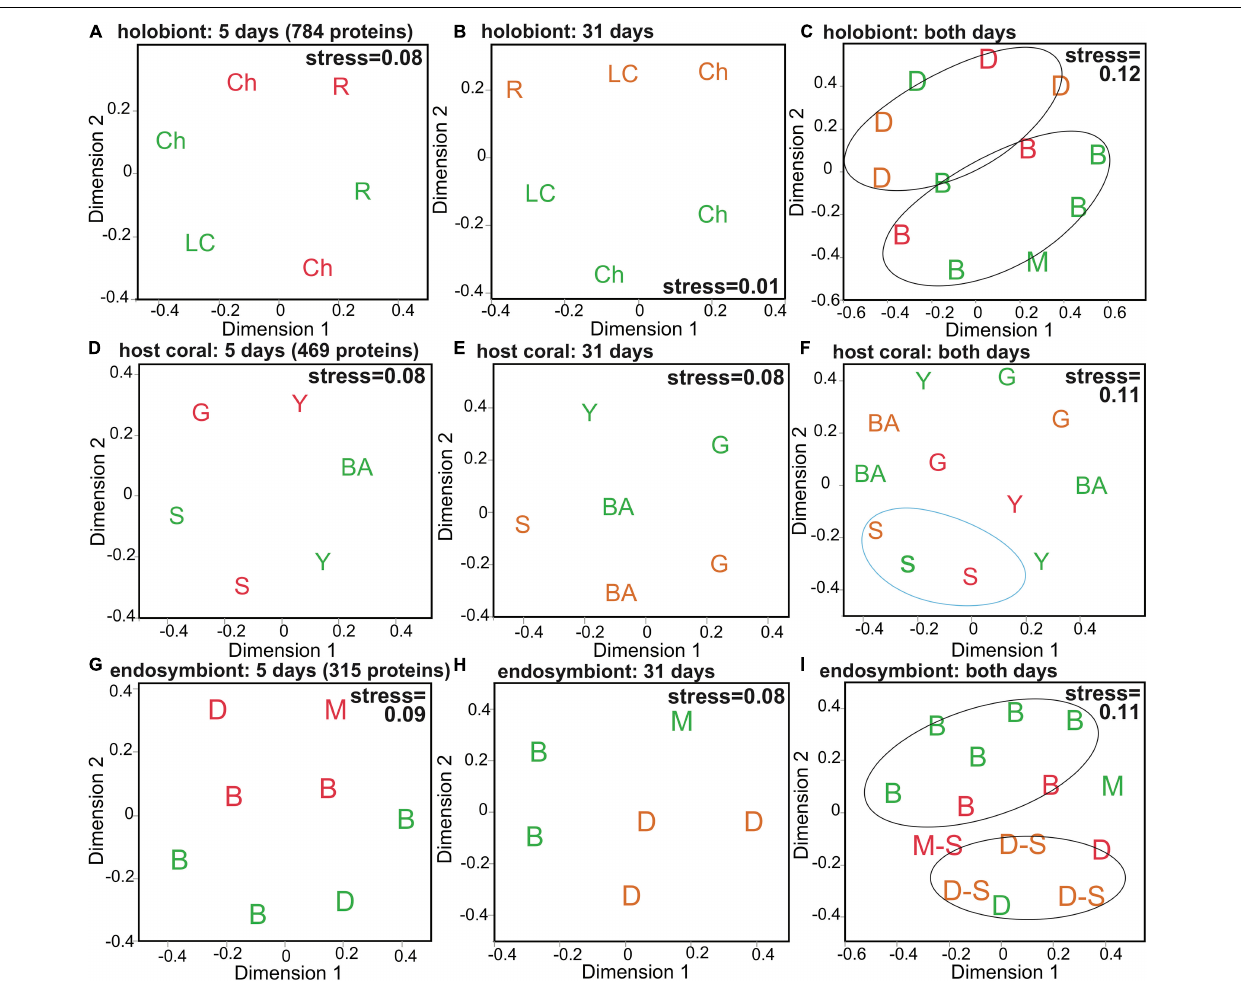
FIGURE 1 | Multivariate analysis of the Orbicella faveolata -Symbiodiniaceae (Sym) proteome. Multi-dimensional scaling (MDS) depicting similarity among samples at the 5-day (A,D,G) , 31-day (B,E,H) , and 5+31-day (C,F,I) sampling times for all 784 holobiont proteins (A–C) , the 469 host coral proteins (D–F) , and the 315 Sym proteins (G–I) . Icons have been coded to denote dominant PERMANOVA effects ( Table 2 ). Site names (A,B) are abbreviated as “Ch” (Cheeca Rocks), “R” (The Rocks), and “LC” (Little Conch); Sym assemblages (C,G–I) as “B” ( Breviolum -dominated), “D” ( Durusdinium -dominated), and “M” (mixed-lineage; Breviolum and Durusdinium ); and host genotypes (D–F) as “S” (skyblue), “G” (grey60), “Y” (lightyellow), and “BA” [black(a)]. In all panels, icons colored green, orange, and red correspond to control (30 ◦ C), high temperature (32 ◦ C), and very high temperature (33 ◦ C) samples, respectively, and samples that were S tressed at the time of sampling have been denoted by “–S” in I